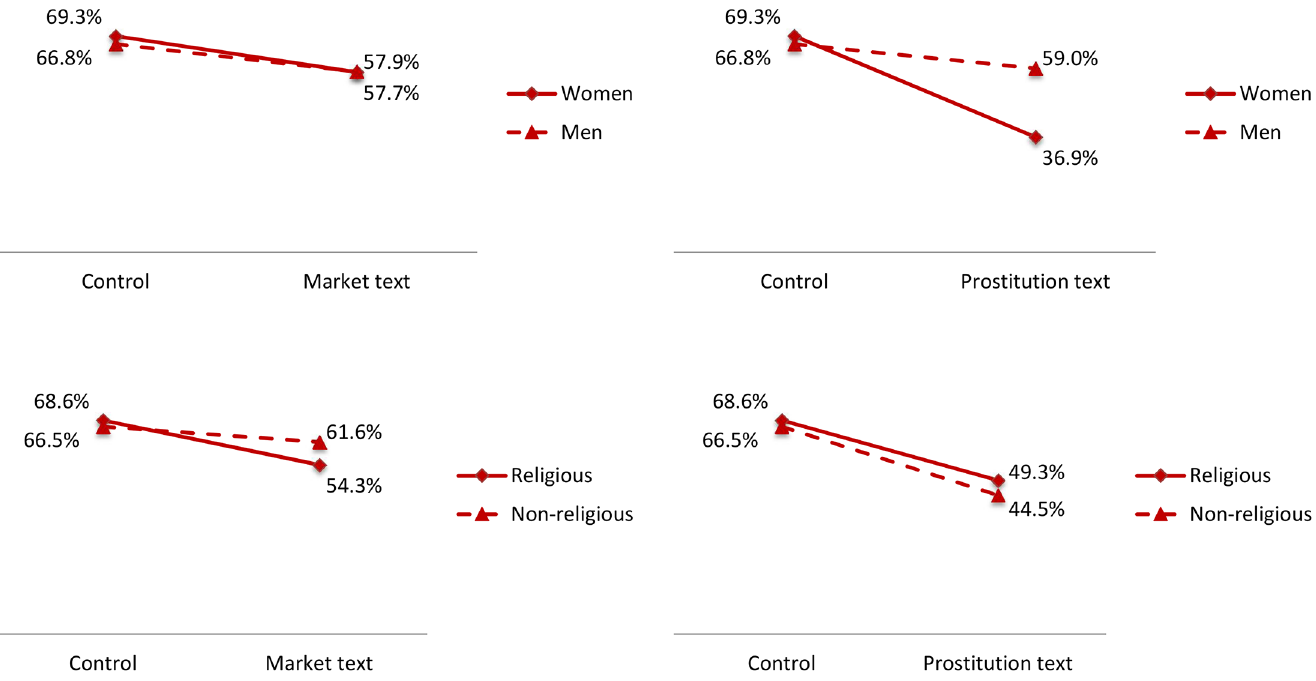
Fig 4. Estimated support for legalizing organ payments, by gender and religiosity. Notes: The figures report the percentage of subjects favoring either payments for organs or legalizing indoor prostitution, by treatment condition and demographic trait. See notes to Fig 2 for details.